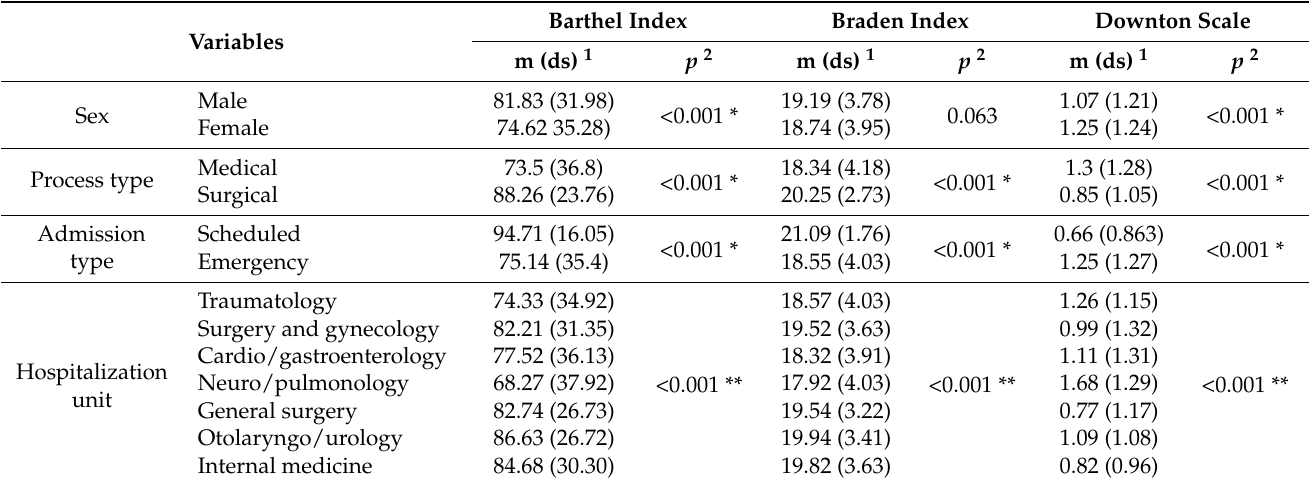
Table 2. Bivariant analysis of nursing assessment